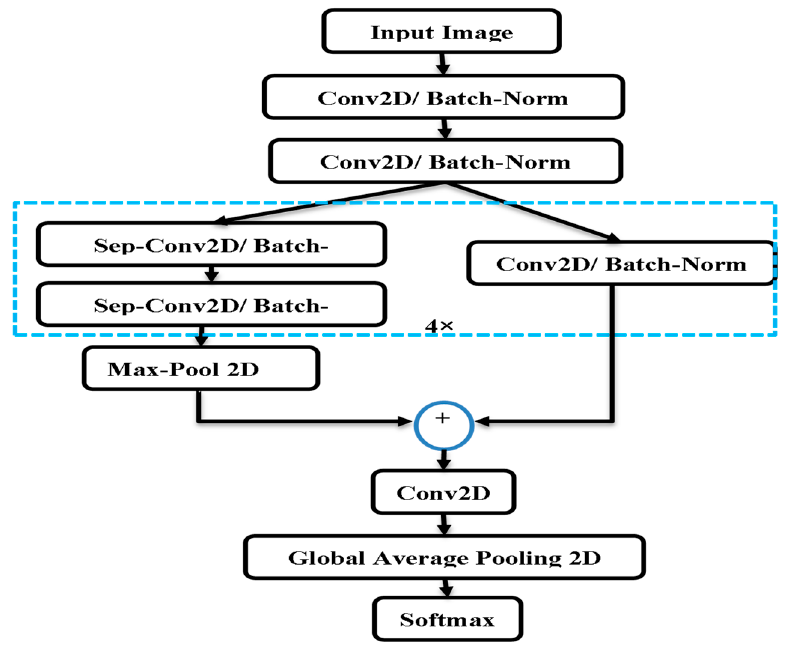
Figure 2. CNN-based facial emotion recognition technique [24]. Algorithm 1: Algorithm of the proposed method.